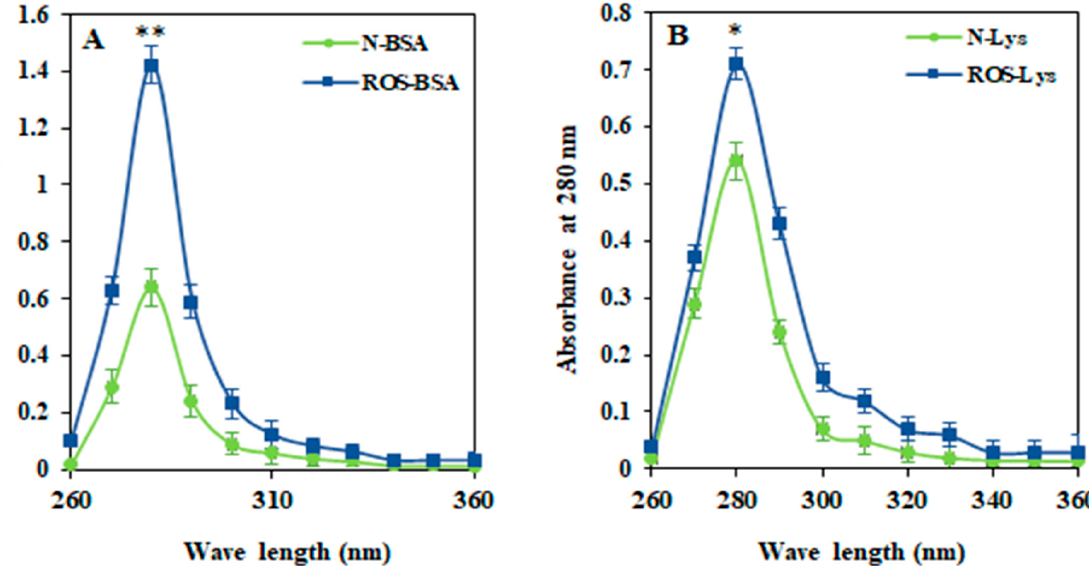
Figure 1. UV spectra of native and free-radical-modified proteins BSA ( A ) and Lys ( B ). The compari- son of UB absorbance intensities between native BSA and ROS-BSA showed ** p < 0.01. Similarly, native Lys and ROS-Lys exhibited * p <